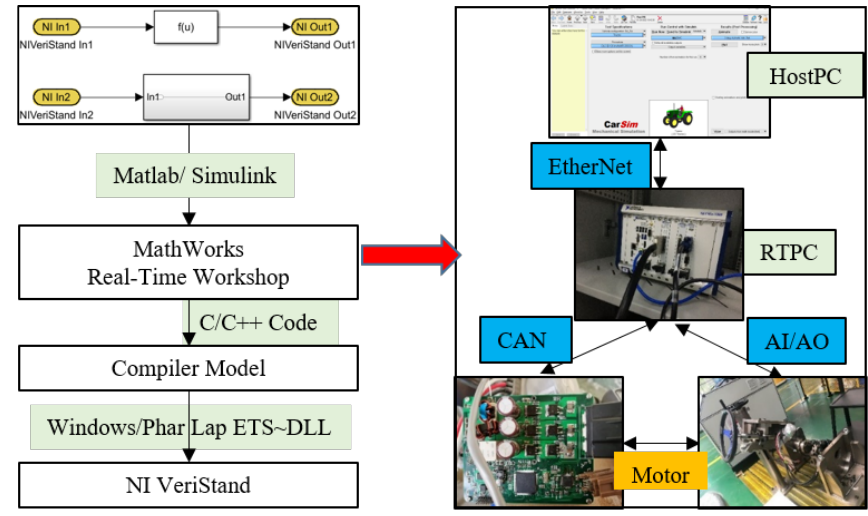
Figure 11. Implementation of the control strategy.